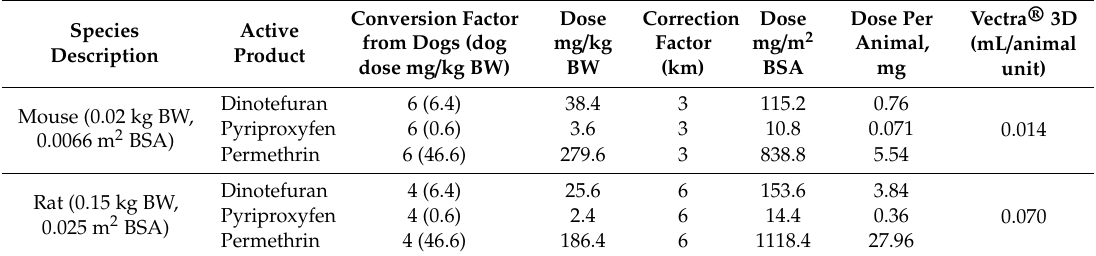
Table 1. Dose calculation of Vectra ® 3D applied on laboratory